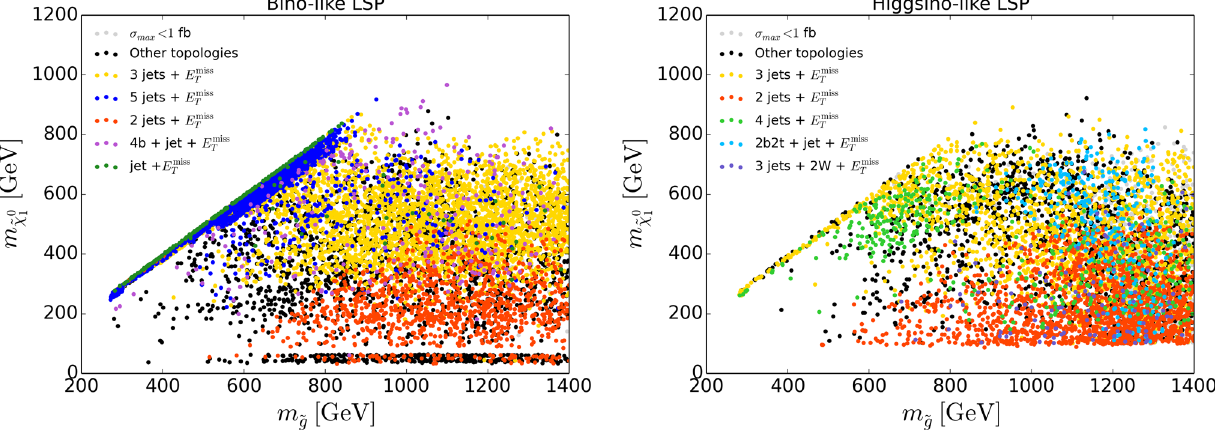
quency of occurrence (points in color). The relevant diagrams, SUSY processes and labeling in SModelS notation are given in Appendix